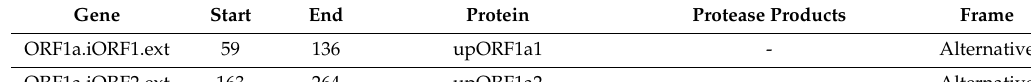
Table 1. Canonical and alternative open reading frames (ORF) in SARS-CoV-2. iORF: internal OPF, extORF: extended ORF, upORF: upstream ORF.